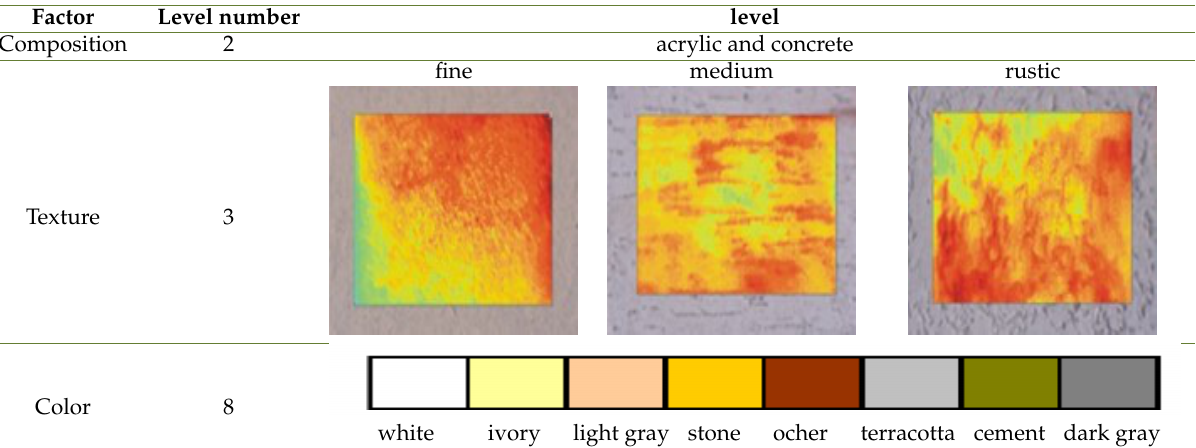
Table 2. Factors and level of analysis of samples. Sources: Author’s own work.